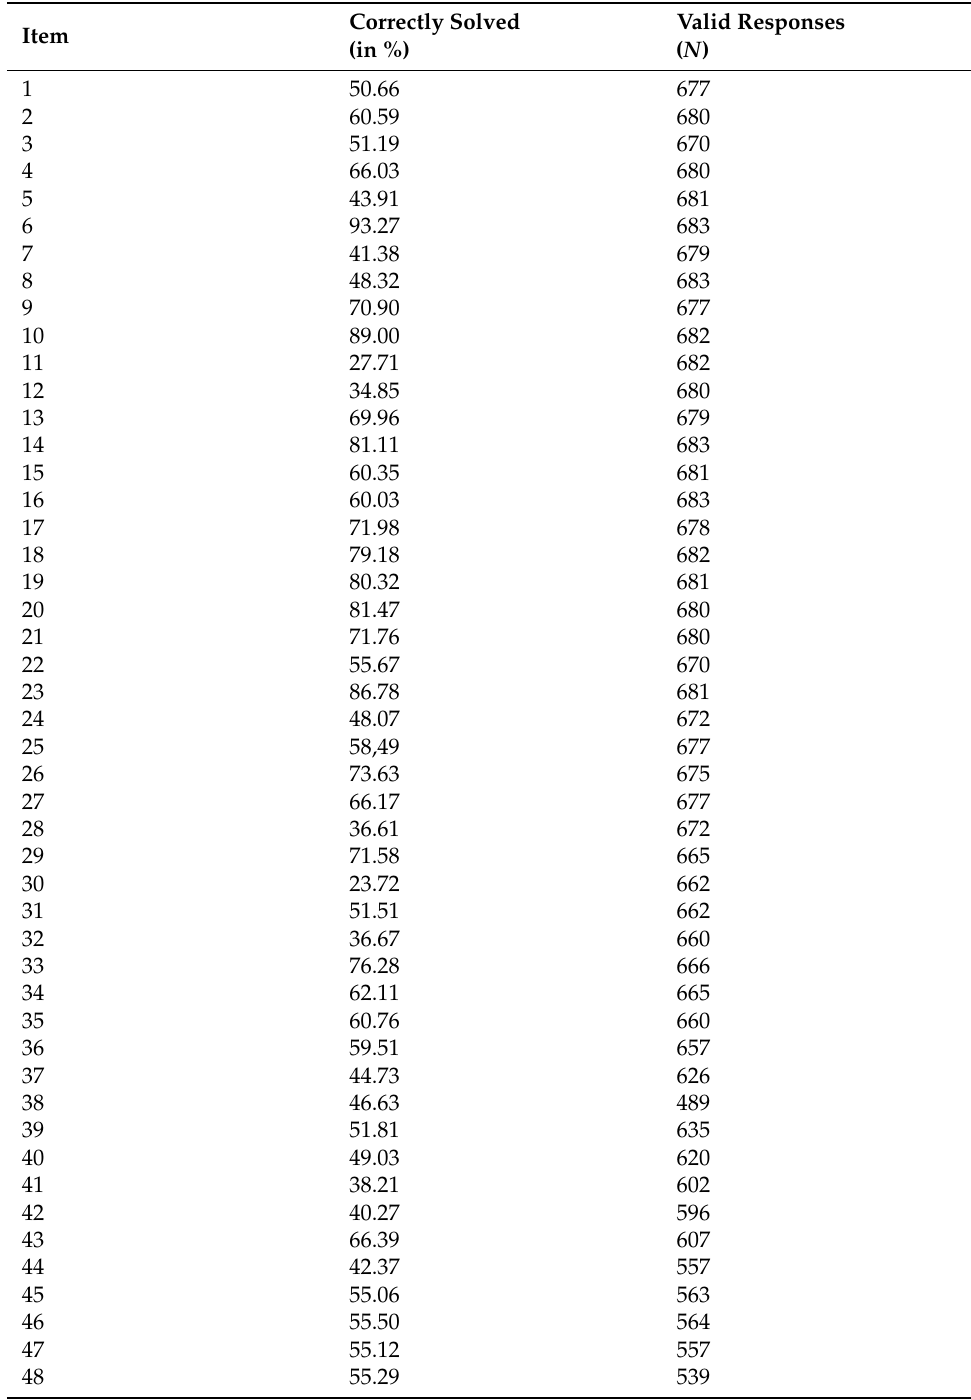
Table 3. Percentage correctly solved and missing responses per